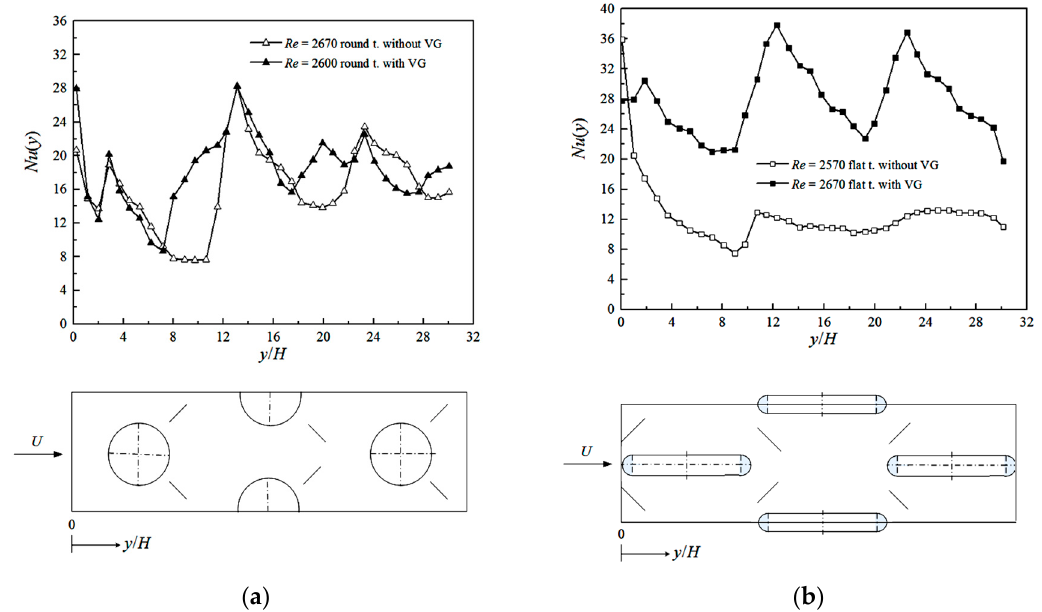
Figure 15. Span-averaged fin Nu number for different fin-tube heat exchangers [29]. ( a ) For round tubes without and with VGs. ( b ) For flat tubes without and with VGs.